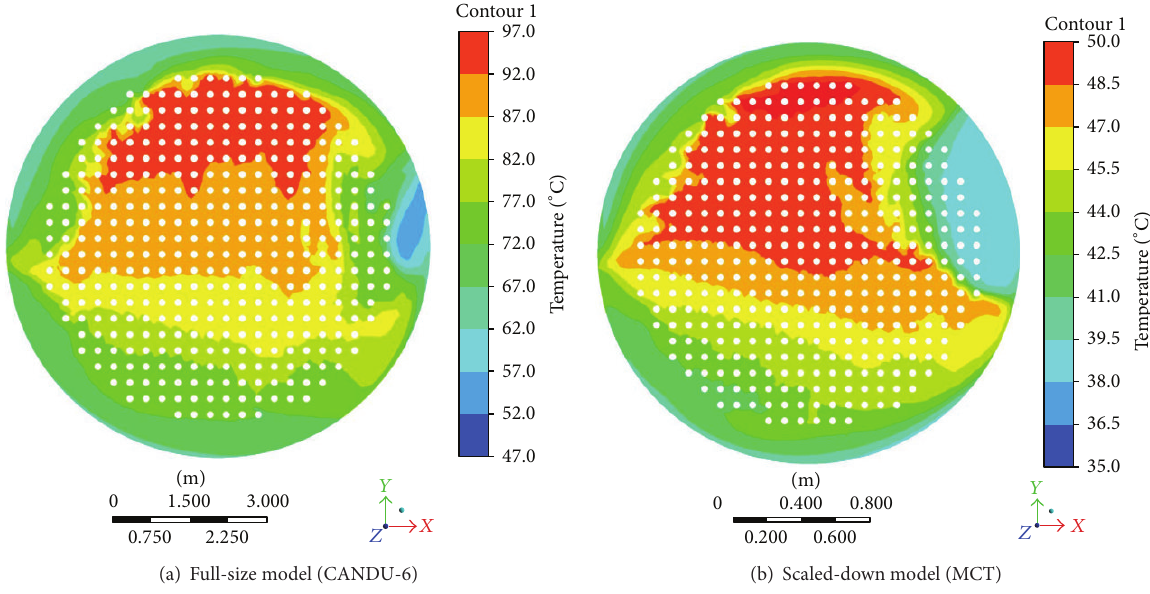
Figure 4: Temperature distribution on the axial center plane.